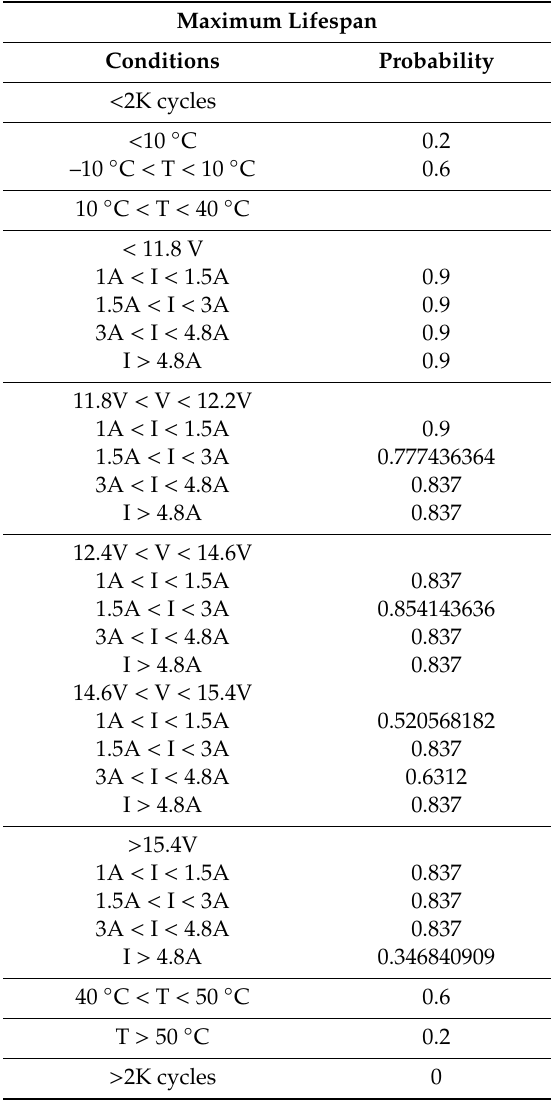
Table 12. Probabilities for overload